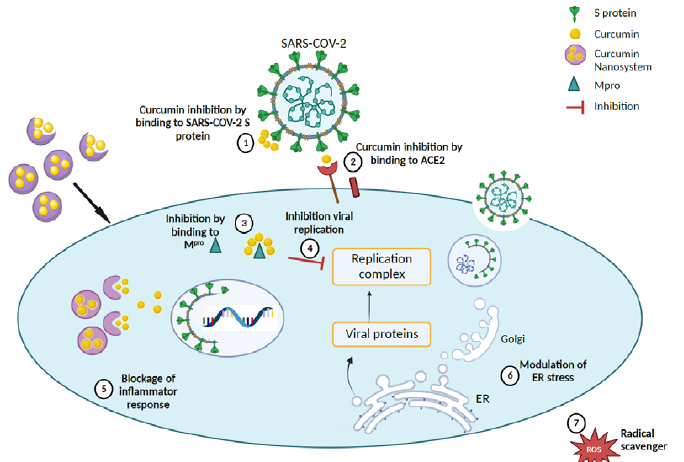
Figure 5. Proposed therapeutic mechanism for curcumin-loaded nanosystems in accordance with literature findings [67,68 ] . (1), (2), and (3) Curcumin nanocarriers inhibit SARS-CoV-2 by delivery of curcumin to bind to the S protein, ACE2 receptor, and Mpro of the coronavirus, thereby (4) impeding the virus replication complex. (5) Curcumin nanocarriers can also block inflammatory response by (6) modulating ER stress and (7) scavenging ROS. (Created with BioRender).